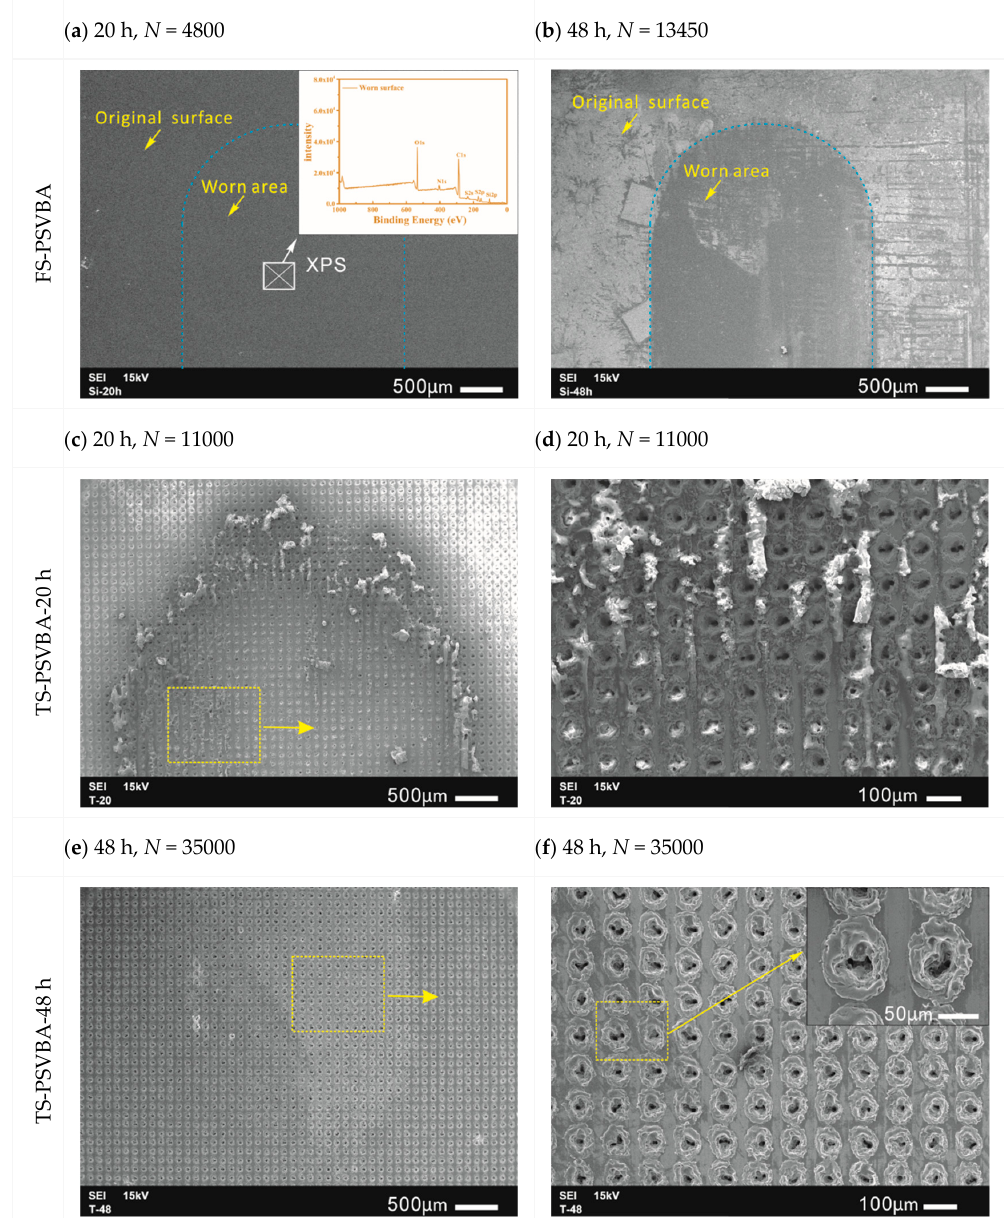
Figure 10. Wear morphology of silicon surface with PSVBA brushes grafted on flat ( a , b ), and textured ( c – f ) surfaces.